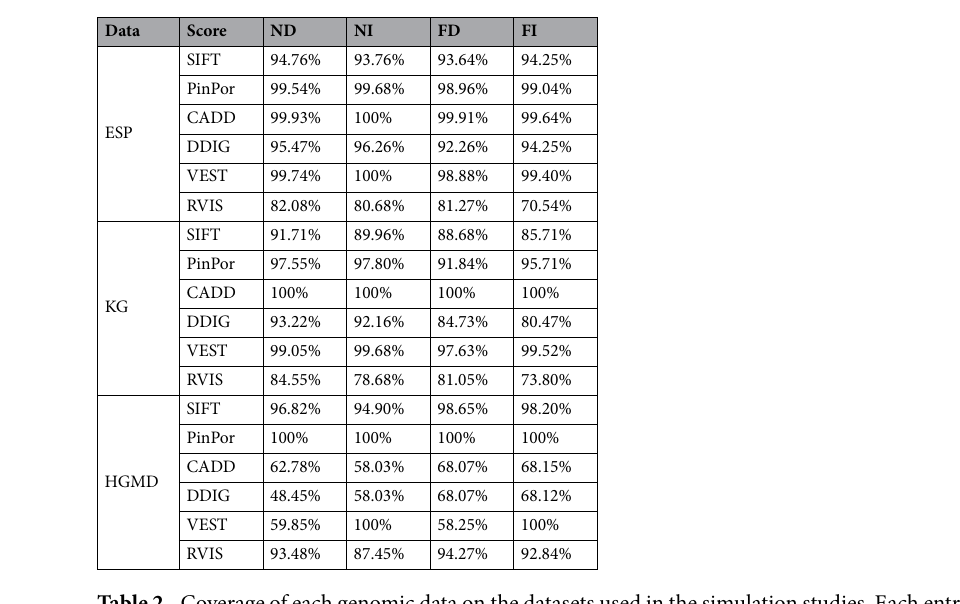
Table 2. Coverage of each genomic data on the datasets used in the simulation studies. Each entry denotes the coverage rate of each genomic data for each indel subtype in the three